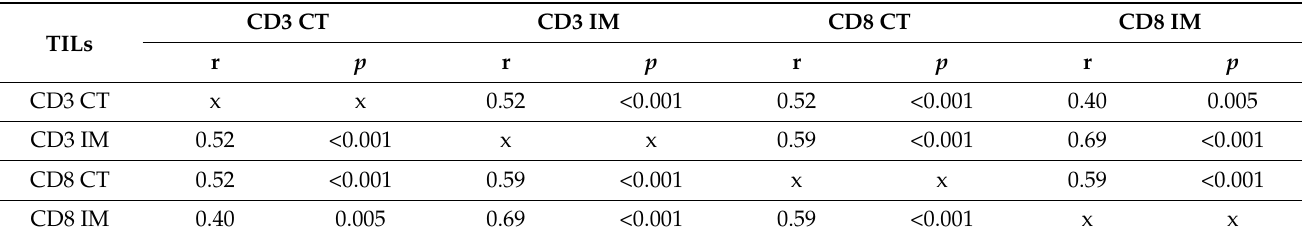
Table 2. Correlation between CD3+ and CD8+ TILs in CT and